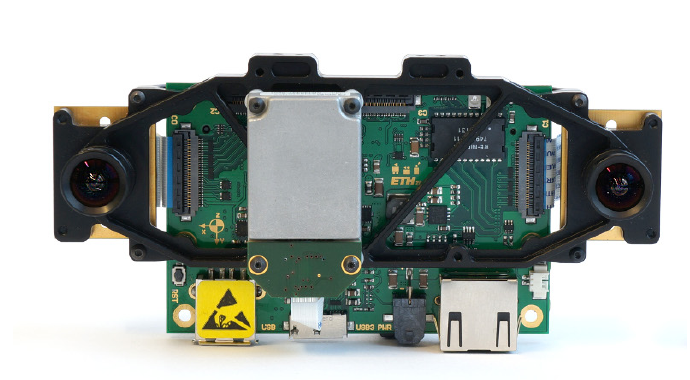
Figure 6. Stereo camera. Skybotix